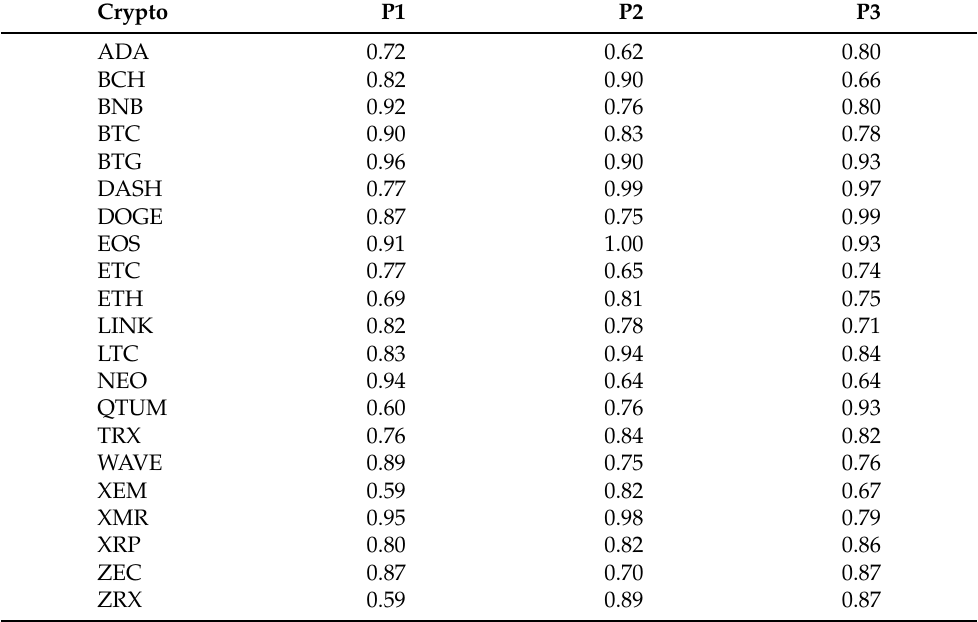
Table 7. Uptrend/Downtrend